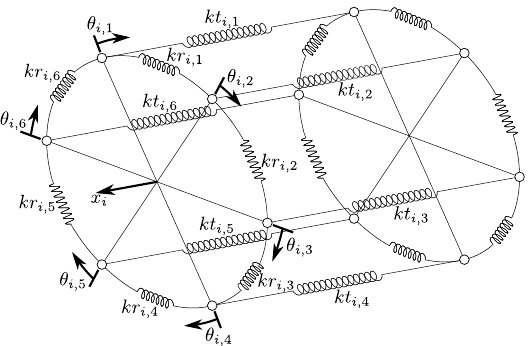
Figure 5. Schematic of the multi-spring TRPT representation. Each ring is represented by N t ( N t = 6 in this design) linear springs with stiffness kr and the tethers by linear springs with stiffness kt . The number of degrees of freedom for a single ring is N t +